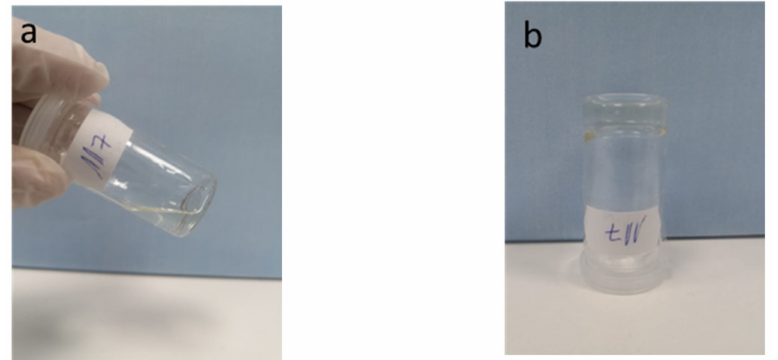
Figure 8. Inversion tube test for G4–CD_7: immediately after mechanical shacking ( a ) and after 100 s left at room temperature ( b